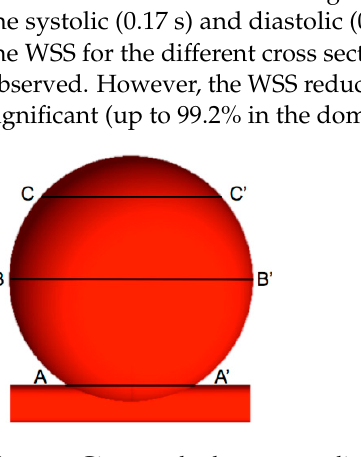
Figure 3. Giant cerebral aneurysm divided into three different cross sections. Table 1. WSS for the systolic cardiac flow.